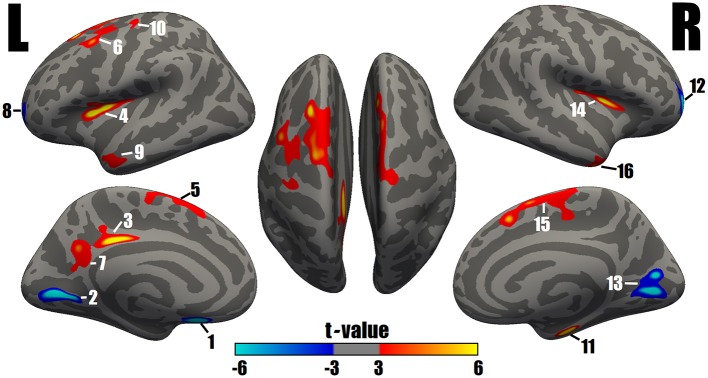
Surface maps of significant differences in cortical thickness between patients with MDD and NCs. As determined by the GLM analysis, differences are presented on an inflated cortical surface (corrected P-value < 0.05). Dark gray indicates a gyrus; light gray indicates a sulcus. “L” indicates the lateral, medial and dorsal surfaces of the left hemisphere. “R” indicates the lateral, medial and dorsal surfaces of the right hemisphere. The color bar represents the t values from −6 to −3 and 3 to 6. Blue indicates cortical thinning in the MDD group compared with the NC group; a closer proximity to sky blue indicates a greater difference. Red to yellow indicates cortical thickening in the MDD group compared with the NC group; a closer proximity to yellow indicates a greater difference. The numerals refer to the cluster numbers listed in Table 2.